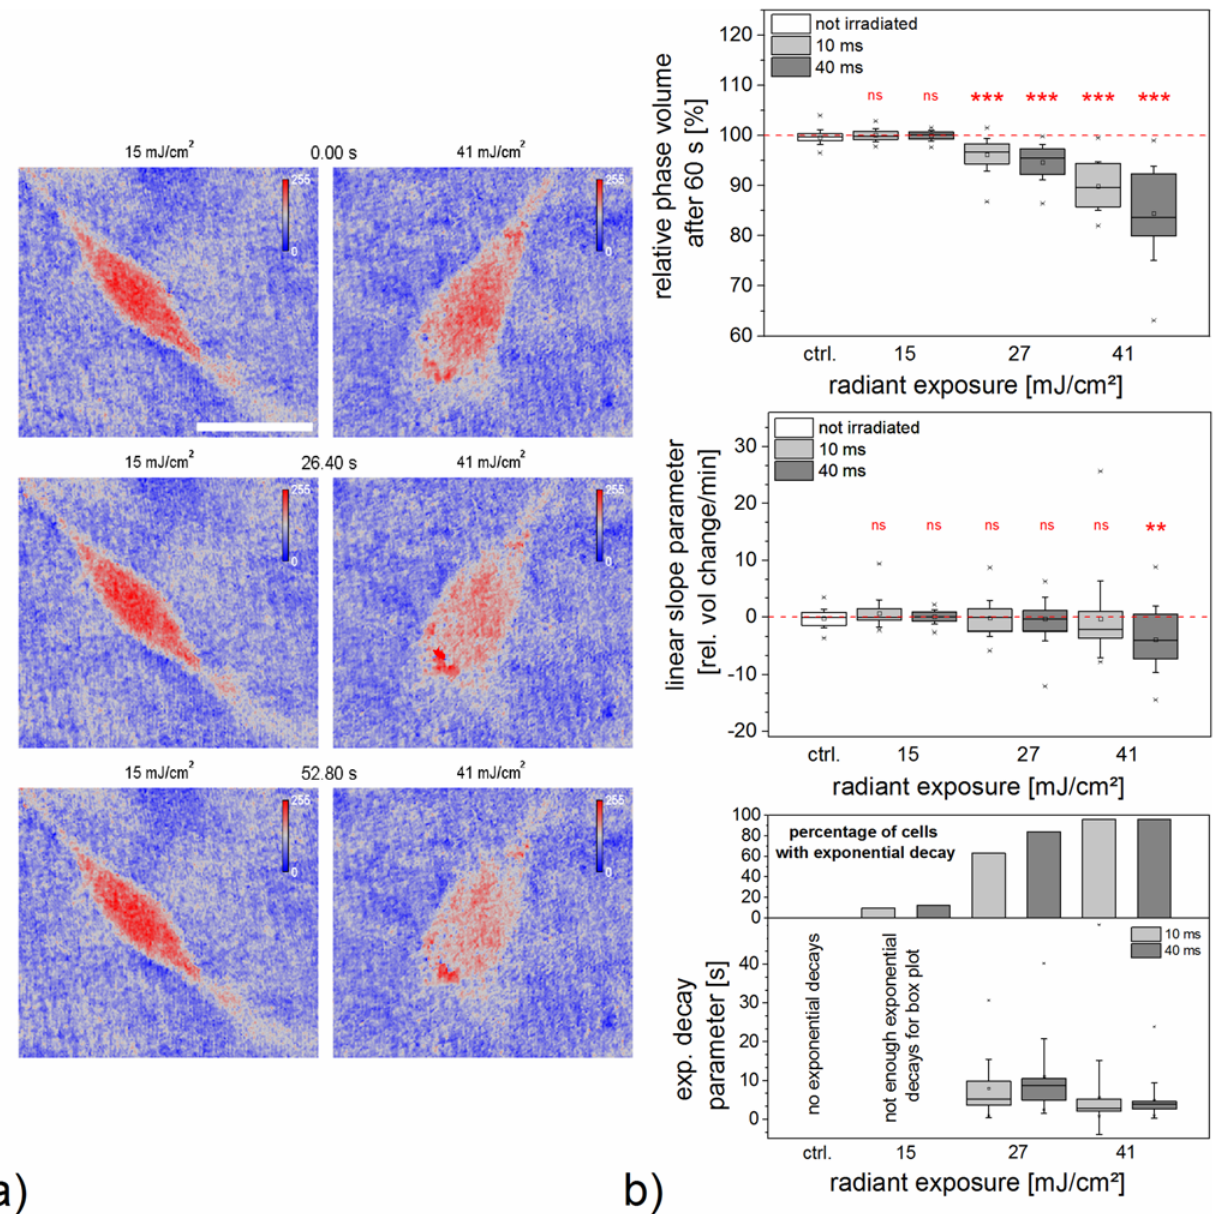
Fig 3. Cell phase volume change evaluated by holographic microscopy. a) Phase images show phase volume and area change after 40 ms irradiation time for two radiant exposures. See corresponding supporting information S1 Video. Scale bars are 20 μ m. b) Shown here are box plots of the fit parameters for the relative phase volume change of cells over a time of 60 s. See supporting information S3 Video. Whiskers for box plots depict one standard deviation. The upper box plot indicates that the total loss of phase volume increases with radiant exposure. The middle box plot presents the linear slope of the fit, which is an indicator of the slow process of cell phase volume change. It can be either positive or negative, corresponding to linear phase volume increase or decrease. In the bottom box plot, the exponential decay parameter is depicted. The percentage of cells, which show a combination of linear and exponential decay is indicated in the upper histogram panel. The graph below this shows the decay constants for those cells which exhibited an exponential volume decay after irradiation. The decay parameter is smallest on average for highest radiant exposure, suggesting fastest loss of volume. Data of at least 22 irradiated cells is